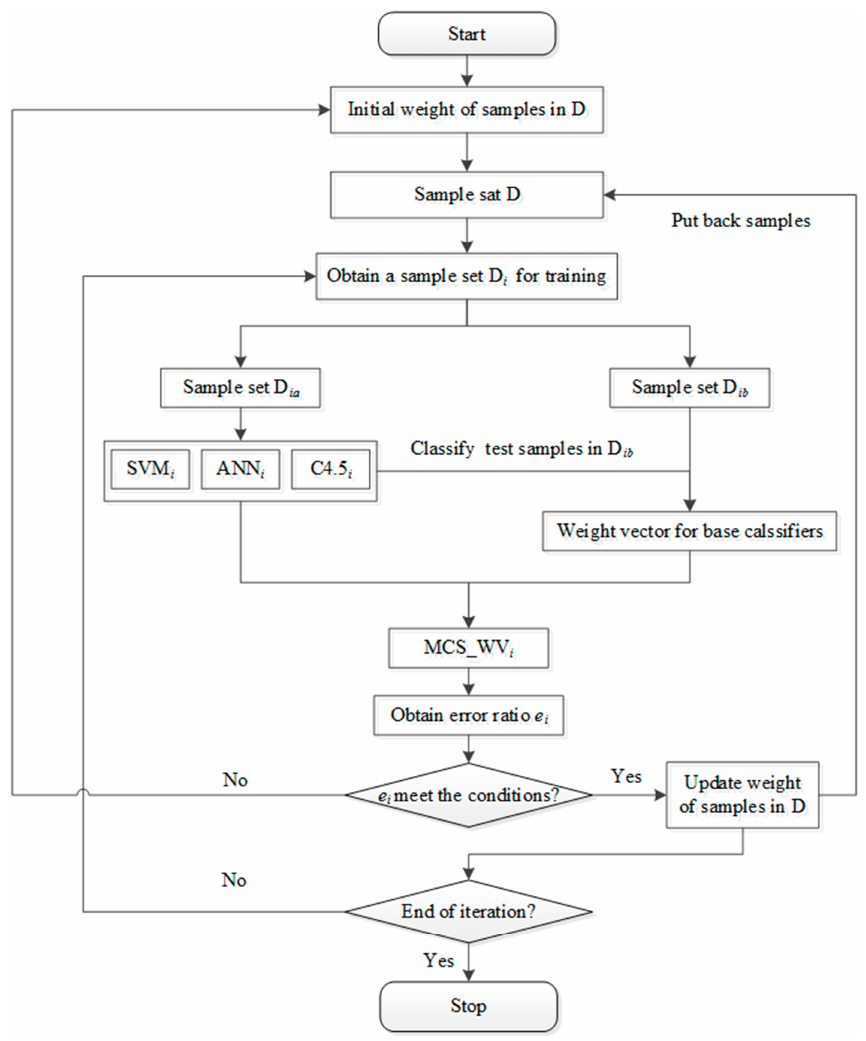
Figure 4. Diagram of MCS_WV_AdaBoost (MCS_WV improved by AdaBoost) training.